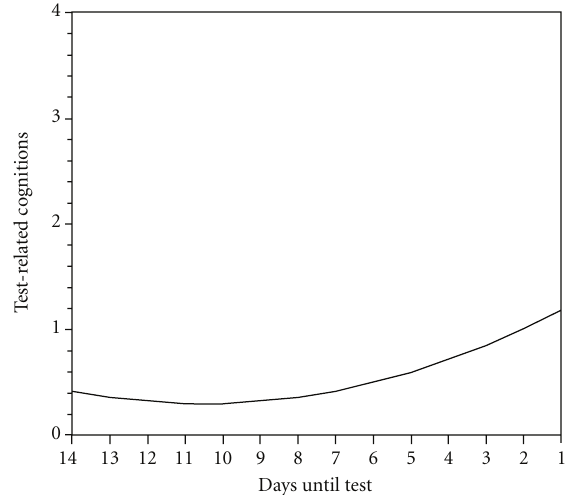
Figure 2: Average intensity of test-related